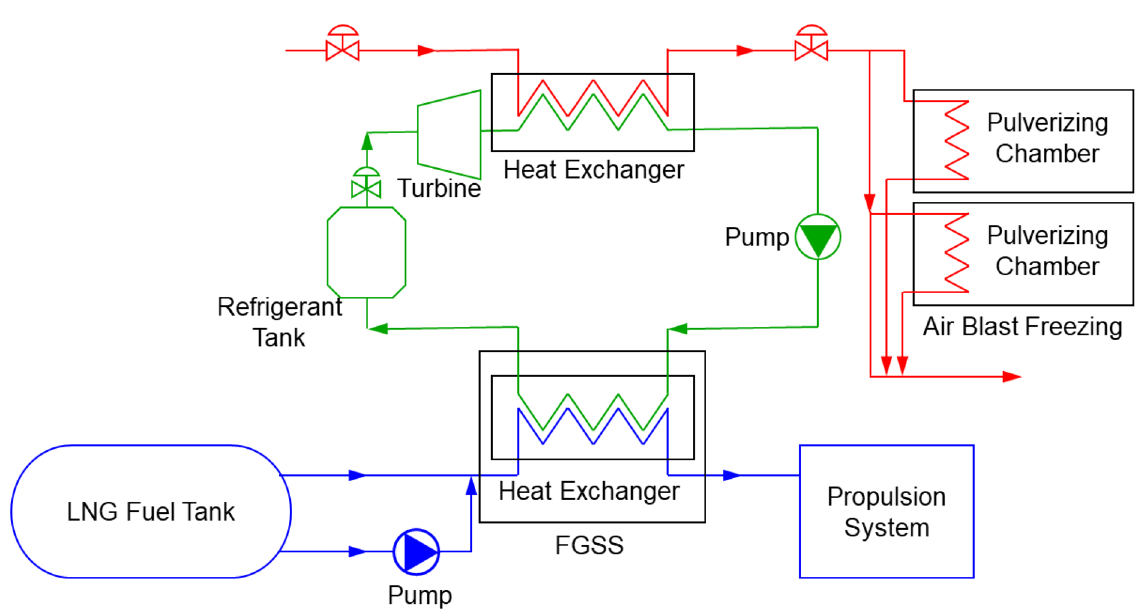
Figure 2. Schematic diagram of proposed LNG-fueled propulsion system with LTP. It contains the LNG propulsion part (blue line), EGW system (green line), and pulverizing chamber with an air-blast freezing system (red